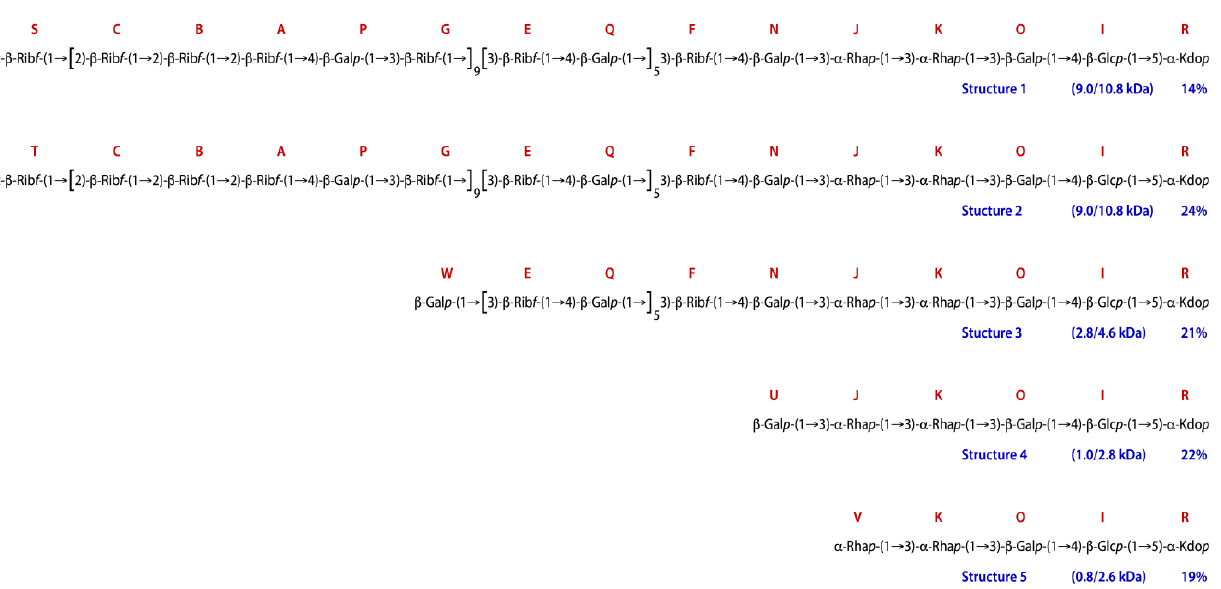
Figure 10. O -polysaccharide and core structures elucidated by the NMR analysis. Proposed core- O -polysaccharide and core-only carbohydrate structures of delipidated Lcres LPS/LOS. The letters correspond to those listed in Table 5. The molecular weights listed in parentheses refer to those of the depicted polysaccharides and to the corresponding LOS/LPS. Table 5. Proton and carbon peak assignments of the delipidated O -polysaccharide from Lcr. Carbon chemical shifts in italics.